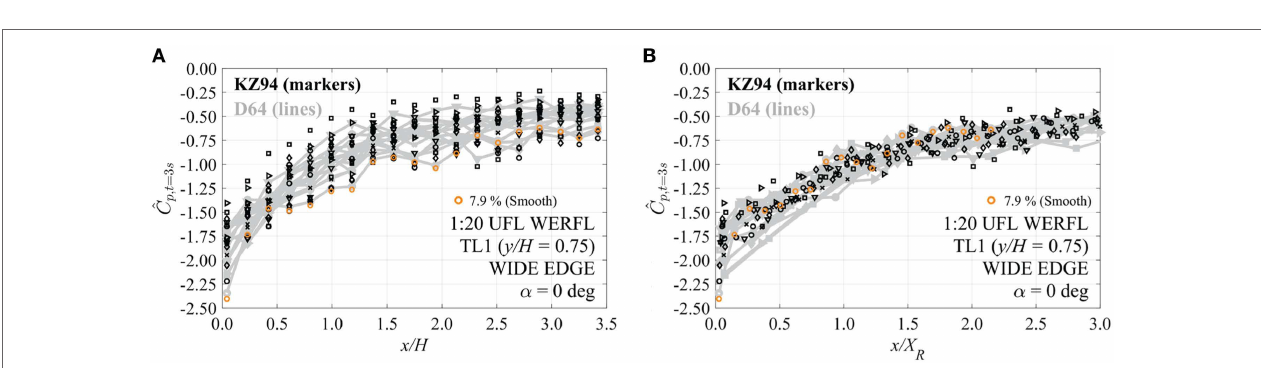
FIGURE 13 | Peak pressure coefficients versus distance from the leading edge normalized by H (A) and X R (B) along tap line TL1 normal. Peak pressures are normalized by the estimated gust velocity at eave height from Davenport (1964) (denoted by D64) and Kareem and Zhao (1994) (denoted by KZ94) peak factor model.